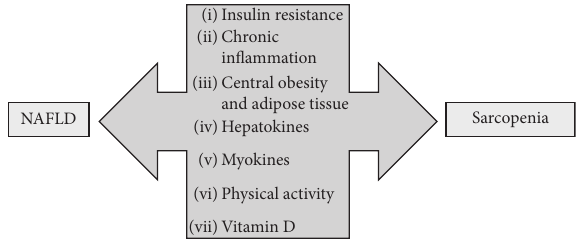
Figure 1: Possible mechanisms of the interaction between NAFLD and sarcopenia. ∗ NAFLD, nonalcoholic fatty liver